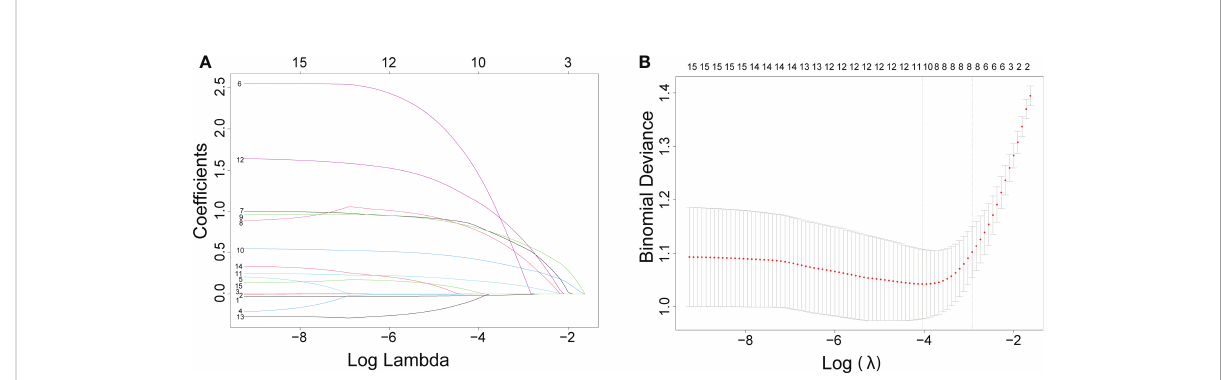
FIGURE 1 The results of the least absolute shrinkage and selection operator (lasso) regression analysis. The coef fi cients of all variables are reduced to 0 from instability to stability in (A) and obtain the model coef fi cient of l value that minimizes the model deviation by cross-validation curve in (B)